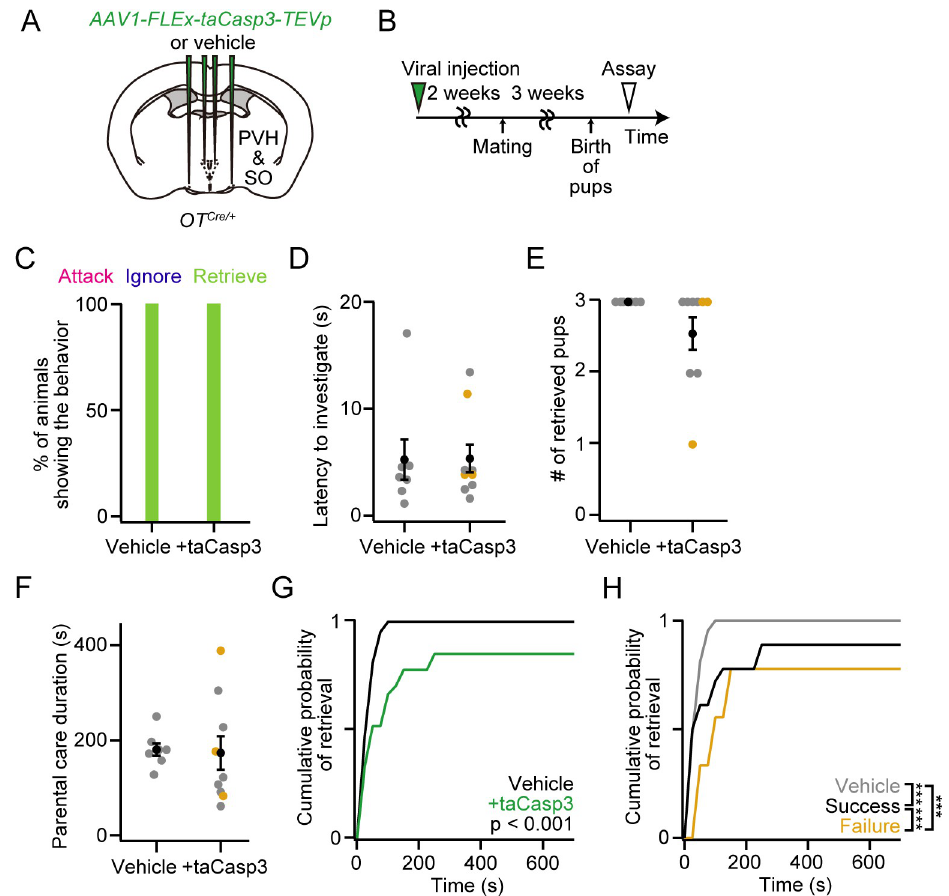
Fig 5. Grossly normal parental behaviors of mothers with cell ablation of OT neurons. (A) Schematic of the viral injection. AAV-FLEx-taCasp3-TEVp or vehicle was injected into the bilateral PVH and SO. (B) Schematic of the timeline of the experiment. A behavioral assay was conducted at PPD 3. (C) Percentage of mothers showing attack, ignore or retrieve. Note that attack or ignore was not observed in our dataset. (D) Latency to the first investigation of pups was not statistically different (two-sided Mann–Whitney U- test). (E) Number of retrieved pups. (F) Parental care duration was not statistically different (two-sided Mann–Whitney U- test). (G) Cumulative probability of pup retrieval. The p-value is shown in the panel (Kolmogorov–Smirnov test). (H) Cumulative probability of pup retrieval of vehicle dams (gray line), and +taCasp3 dams that exhibited success (black line) or failure (orange line) in raising pups at PPD 1 ( ��� p < 0.001, Kolmogorov–Smirnov test with Bonferroni correction). n = 6 and 3 for the success and failure phenotypes, respectively. n = 7 and 9 for vehicle and +taCasp3 from the mice analyzed in Fig 4D, respectively. Orange dots indicate mothers with the failure phenotype. Error bars, standard error of the